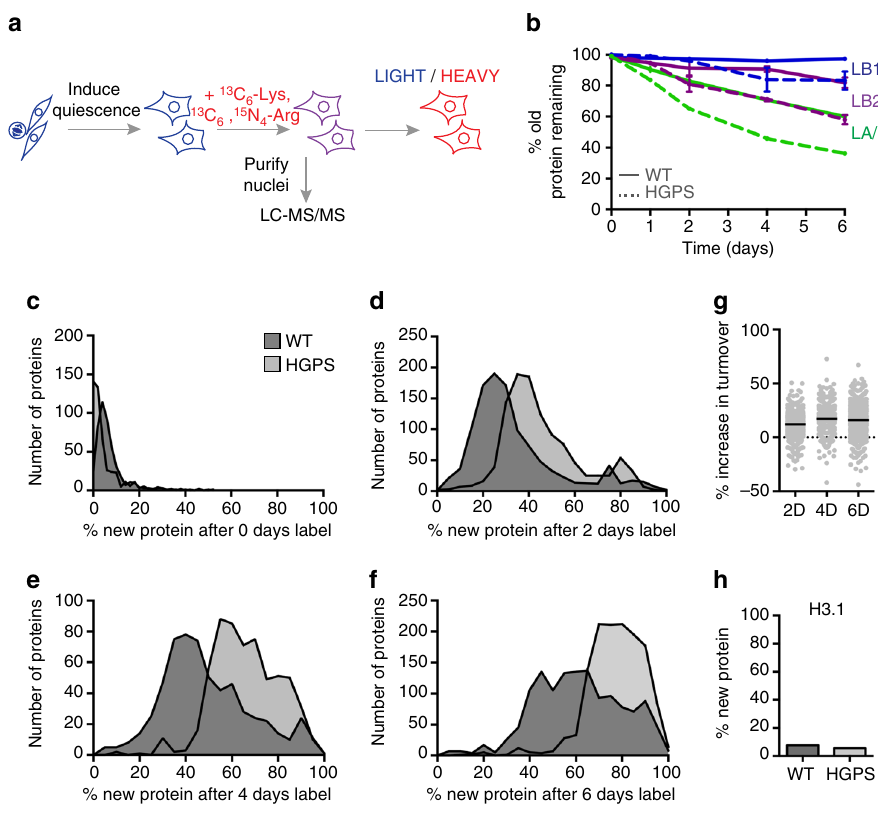
Fig. 1 SILAC analysis of protein stability in HGPS. a Overview of SILAC experiment strategy in quiescent fi broblasts. Sub-con fl uent fi broblast cultures were cultured in low serum to induce quiescence for 3 days before initiating a 6-day 13 C 6 -Lys, 13 C 6 / 15 N 4 -Arg pulse-labeling timecourse. b Extent of lamin protein turnover quanti fi ed by % 12 C 6 -Lys, 12 C 6 / 14 N 4 -Arg-labeled proteins remaining ( “ old ” ) in WT cells ( solid lines ) and HGPS cells ( dashed lines ). LA/C, Lamin A/C; LB1, Lamin B1; LB2, Lamin B2. Mean ± SEM of all detected peptides shown. Peptide coverage was as follows: WT, LA/C 0D, n = 262; LA/C 1D, n = 41; LA/C 2D, n = 245; LA/C 4D, n = 140; LA/C 6D, n = 294. LB1 0D, n = 52; LB1 2D, n = 29; LB1 4D, n = 8; LB1 6D, n = 22. LB2 0D, n = 59; LB2 2D, n = 21; LB2 4D, n = 8; LB2 6D, n = 25. HGPS, LA/C 0D, n = 16; 1D, n = 114; 2D, n = 234; 4D, n = 80; 6D, n = 239. LB1 0D, n = 2; 1D, n = 7; 2D, n = 21; 4D, n = 6; 6D, n = 14. LB2 0D, n = 2; 1D, n = 9; 2D, n = 17; 4D, n = 1; 6D, n = 22. c – f Extent of protein turnover quanti fi ed by %protein labeled with 13 C 6 -Lys and 13 C 15 N “ new ” ) after no label ( c , 473 proteins); 2 days label ( d , 1102 proteins), 4 days label ( e , 603 proteins), or 6 days label ( f , 1343 proteins). 6 , 4 -Arg ( Turnover values were plotted for proteins detected by LC-MS/MS in both wild type (AG3258) and HGPS (AG11498) cells with at least two peptides at each time point shown. Distributions were signi fi cantly different at each time point ( p < 0.0001); signi fi cance determined by unpaired t -test with Welch ’ s correction. g %increase in protein turnover in HGPS cells proteome-wide after 2 days labeling (median increase 12.1%), 4 days labeling (median increase 17.3%), or 6 days labeling (median increase 15.8%). Black bars indicate median. h %new Histone H3.1 detected after 2 days labeling in WT and HGPS cells based on the single tryptic peptide unique to H3.1. See also Supplementary Data